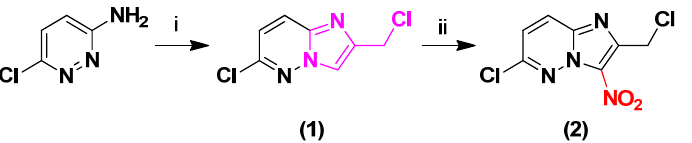
Figure 1. Scaffold ‐ hopping strategy of 3 ‐ nitroimidazo[1,2 ‐ a ]pyridine moiety into 3 ‐ nitroimid ‐ azo[1,2 ‐ b ]pyridazine moiety.